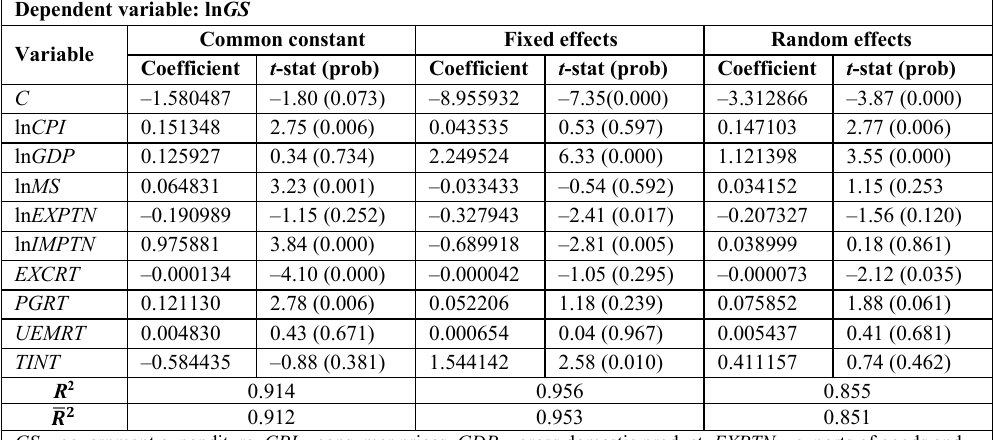
Table 3. The Result from Panel Least Square